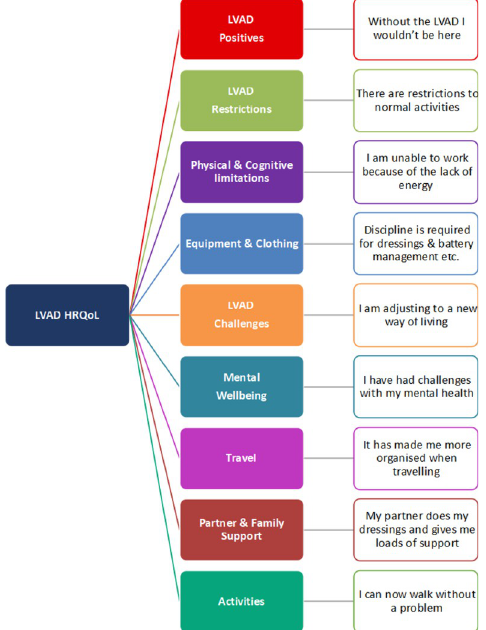
Fig 4. LVAD HRQoL conceptual framework. Conceptual framework based on clusters and statements within identifying key domains and items that are important to LVAD